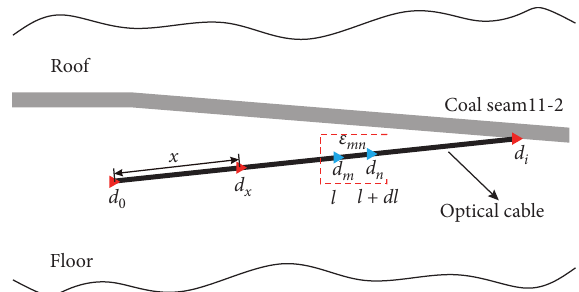
Figure 5: Calculation model of axial deformation along the optical